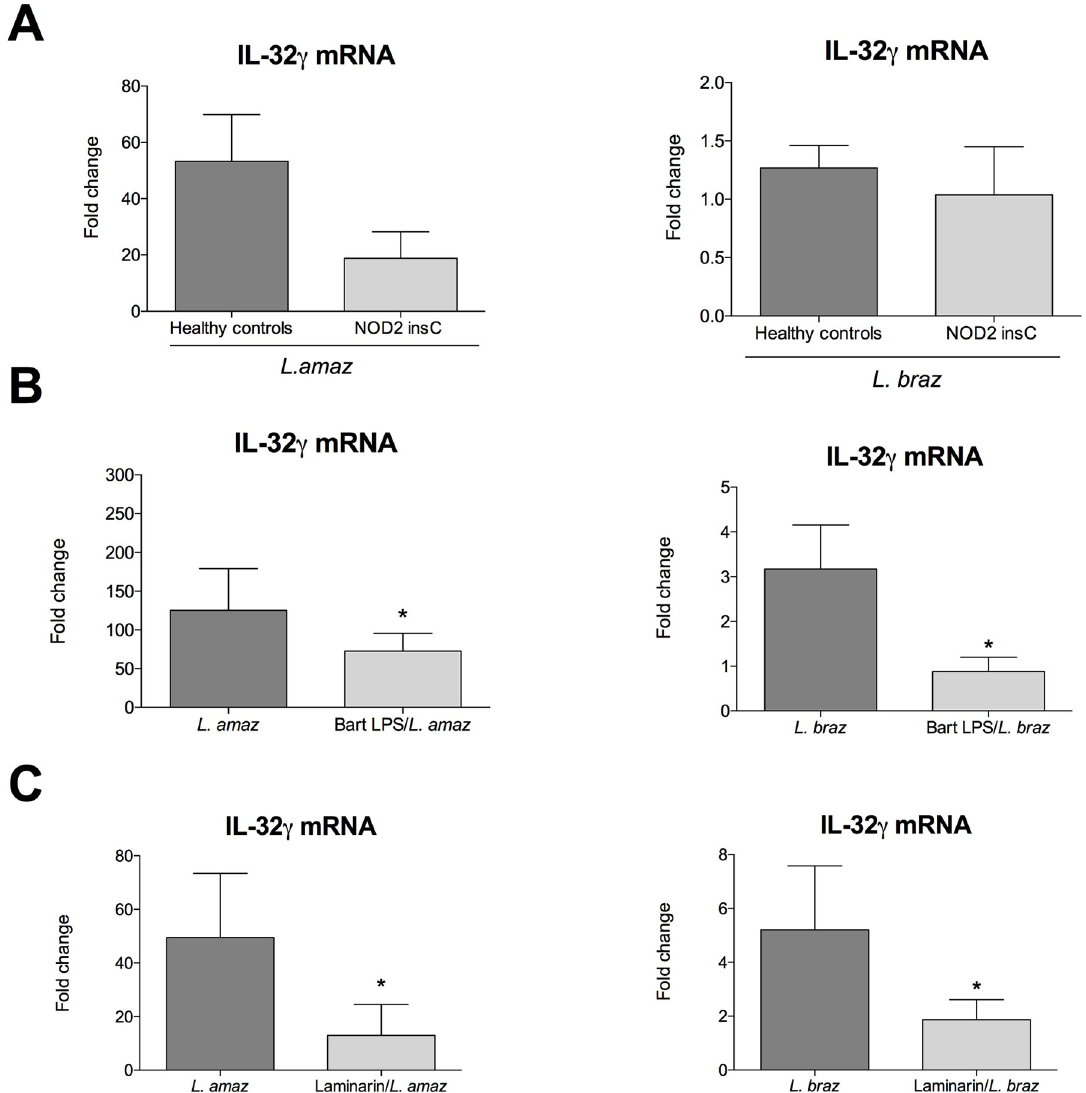
Fig 2. IL-32 γ gene expression was measured in PBMCs from healthy controls carrying no mutation in NOD2 (n = 6) and from individuals carrying a mutation in NOD2 receptor (3020insC) (n = 3) after 24 hours exposure with lysates (50 μ g/mL) of L . amazonenis and L . braziliensis (A-B). IL-32 γ gene expression measured in PBMCs from healthy individuals (n = 6) pre-incubated 1 hour in the presence of Bartonella quintana LPS (Bart LPS—5 μ g/mL) and with laminarin (100 μ g/mL) followed by stimulation with lysates of L . amazonenis and L . braziliensis (B-C). Results are compiled from at least two independent experiments. The data shown are the mean ± SEM, n = 6. � p < 0.05 ( Leishmania spp. vs Leishmania spp. in the presence of Bart LPS or laminarin, Wilcoxon